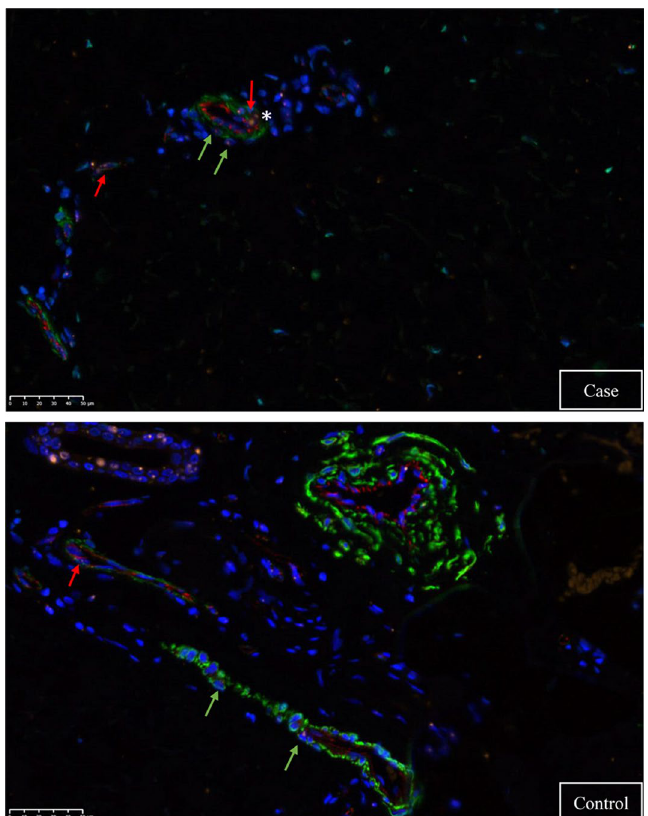
Figure 3. In situ hybridization of E2F4 in dermis. Fluorescence for E2F4 is shown in orange, for CD31 in red and for αSMA in green. The image above corresponds to a case and the image below to a control. The red arrows indicate E2F4 positivity in a CD31-positive cell. Green arrows indicate E2F4 positivity in an SMA-positive cell. The asterisk indicates an E2F4 cluster.